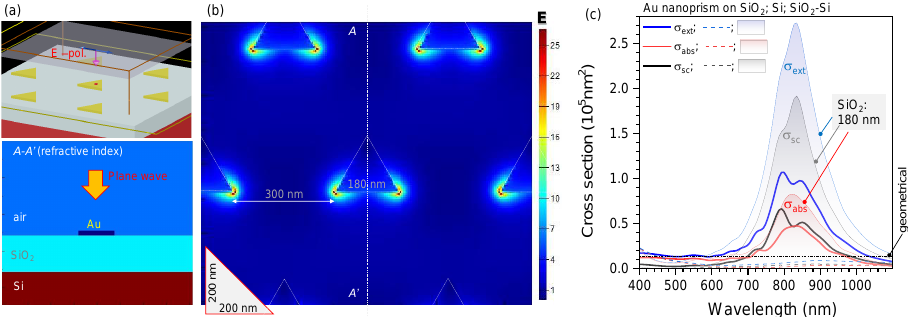
Figure 2. ( a ) 3D finite difference time domain (FDTD) setting for calculations under linearly polarised (along x-axis) E-field; plane wave illumination. Refractive index cross section ( A-A’ ). ( b ) E-field E / E 0 cross section at the middle-plane of 30-nm-thick Au nano-particles (15 nm above SiO 2 ). The incident field | E 0 | = 1. The maximum field cross section shown is at λ = 825 nm as in the experiment, see text for discussion. ( c ) Absorption, scattering and extinction cross sections σ ext = σ abs + σ sc for the L = 180 nm nanoprism on SiO 2 (solid lines; refractive index n = 1.4), Si (dashed-lines), and SiO 2 ( w = 180 nm)-on-Si; optical properties of Si were taken from the material database of Lumerical. The FDTD calculations were carried out using total-field scattered-field (TFSF) light source. Geometrical cross-section corresponds to the footprint area of the nanoprism S Au =